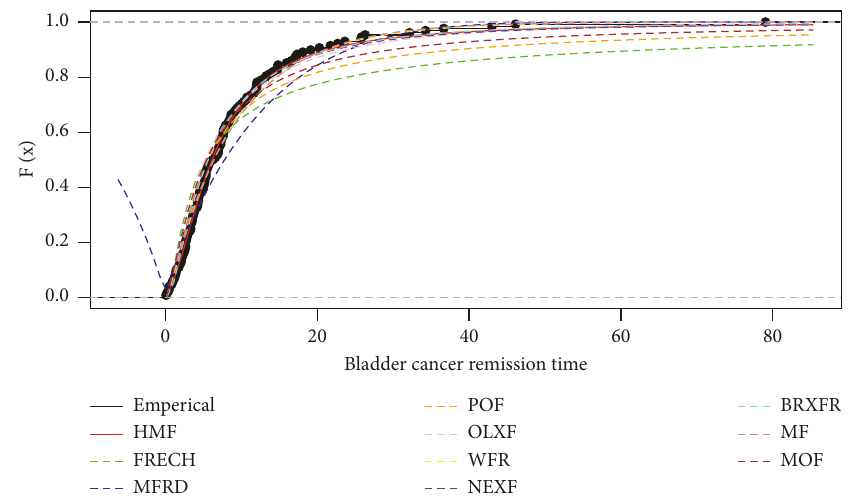
Figure 8: Fitted CDFs for bladder cancer survival time